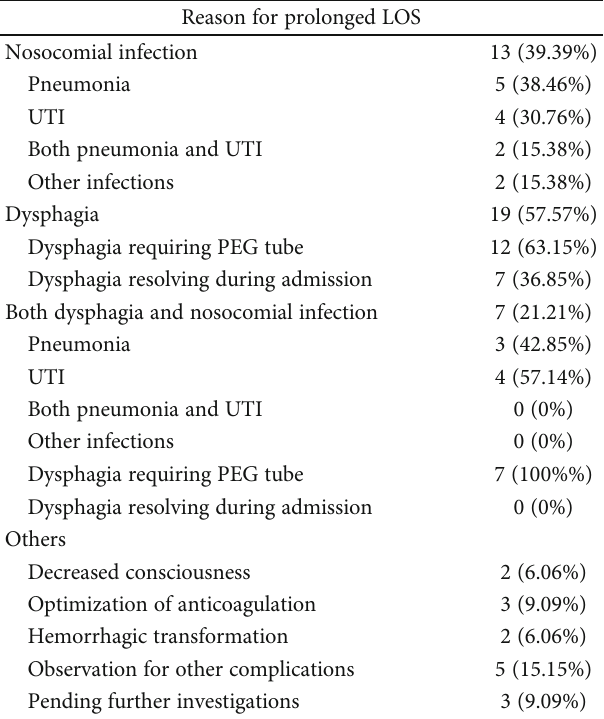
Table 5: Reasons for prolonged LOS. Abbreviations: urinary tract infection: UTI; Percutaneous endoscopic gastrostomy: PEG. Note: classi fi cation is not mutually